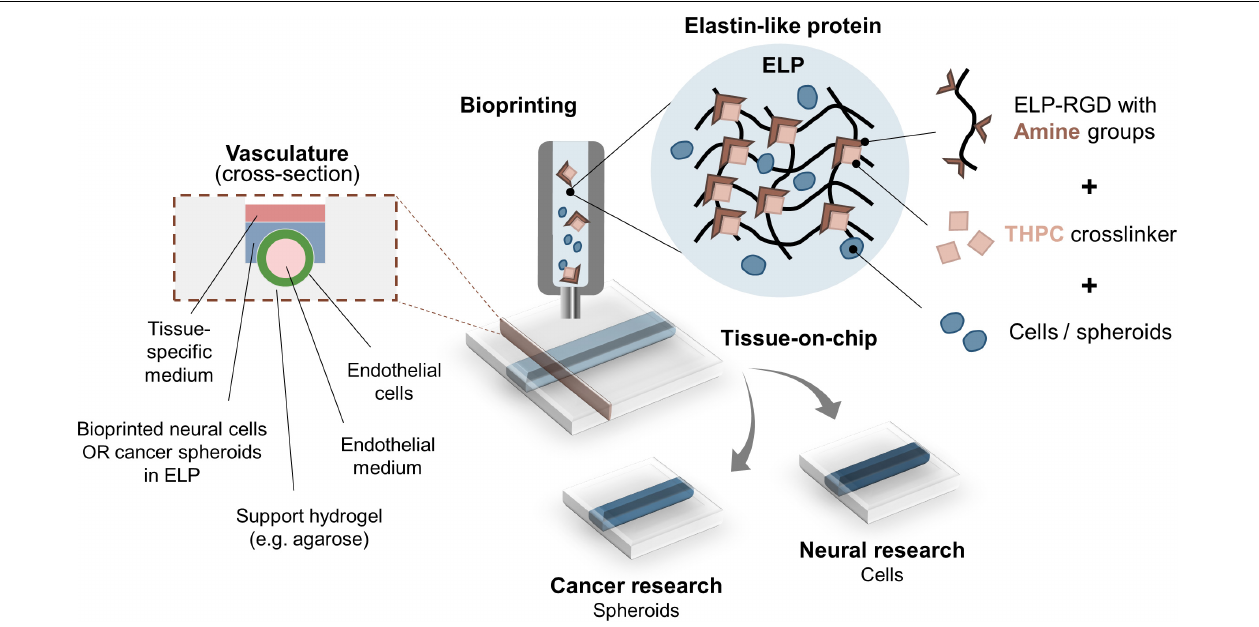
FIGURE 1 | Bioprinting ELP-RGD bioinks with encapsulated cells or spheroids as tissue-on-chip platforms. ELP-RGD bioinks with pendant primary amine groups crosslink in the presence of tetrakis(hydroxymethyl)phosphonium chloride (THPC), which is a tetra-functional, amine-reactive, small molecule crosslinker. Pre-mixed ELP-RGD/THPC bioinks with cells or spheroids are loaded into the bioprinting cartridge and bioprinted directly onto microfluidic chips that enable fabrication of endothelialized vascular-like channels. Two distinct types of culture media are used: endothelial medium is perfused in the lumen of the vascular channel, while neural- or cancer-specific medium is added to the upper culture